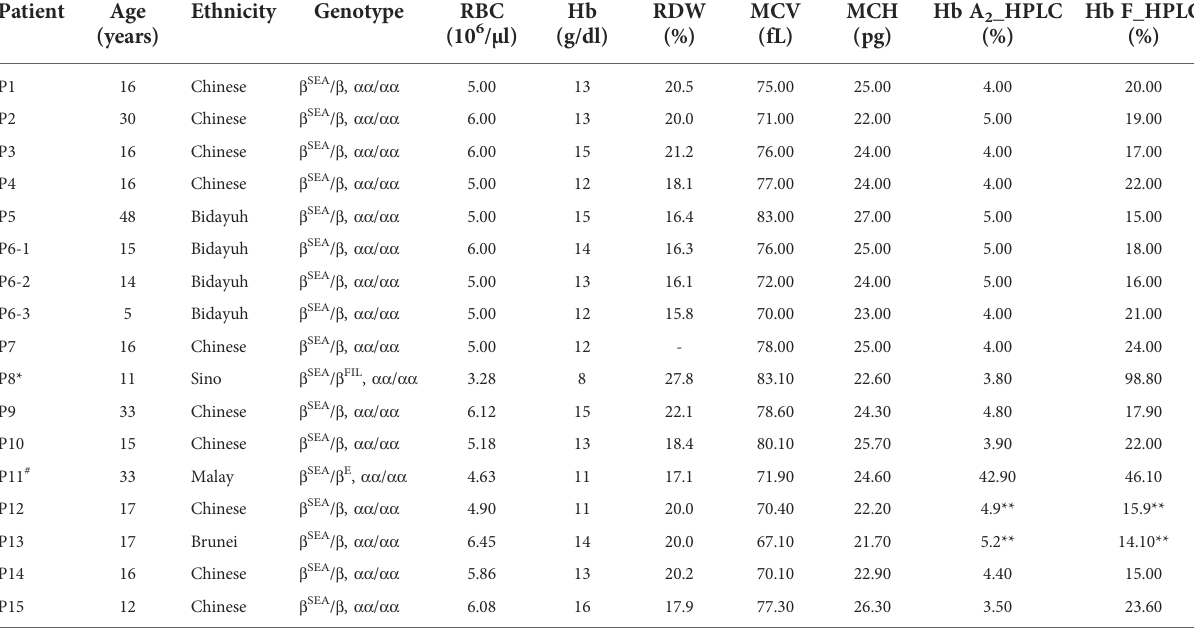
TABLE 2 Hematological parameters and Hb pro fi les of 17 individuals with β °-thal SEA deletion.